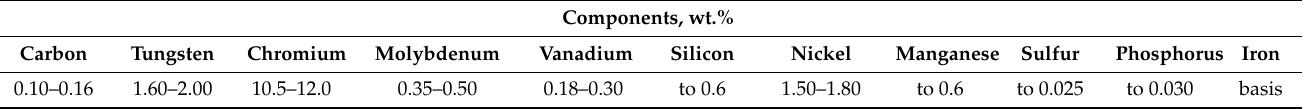
Table 1. Chemical Composition of the Stainless Steel EI961Sh Counterface. Components, wt.%